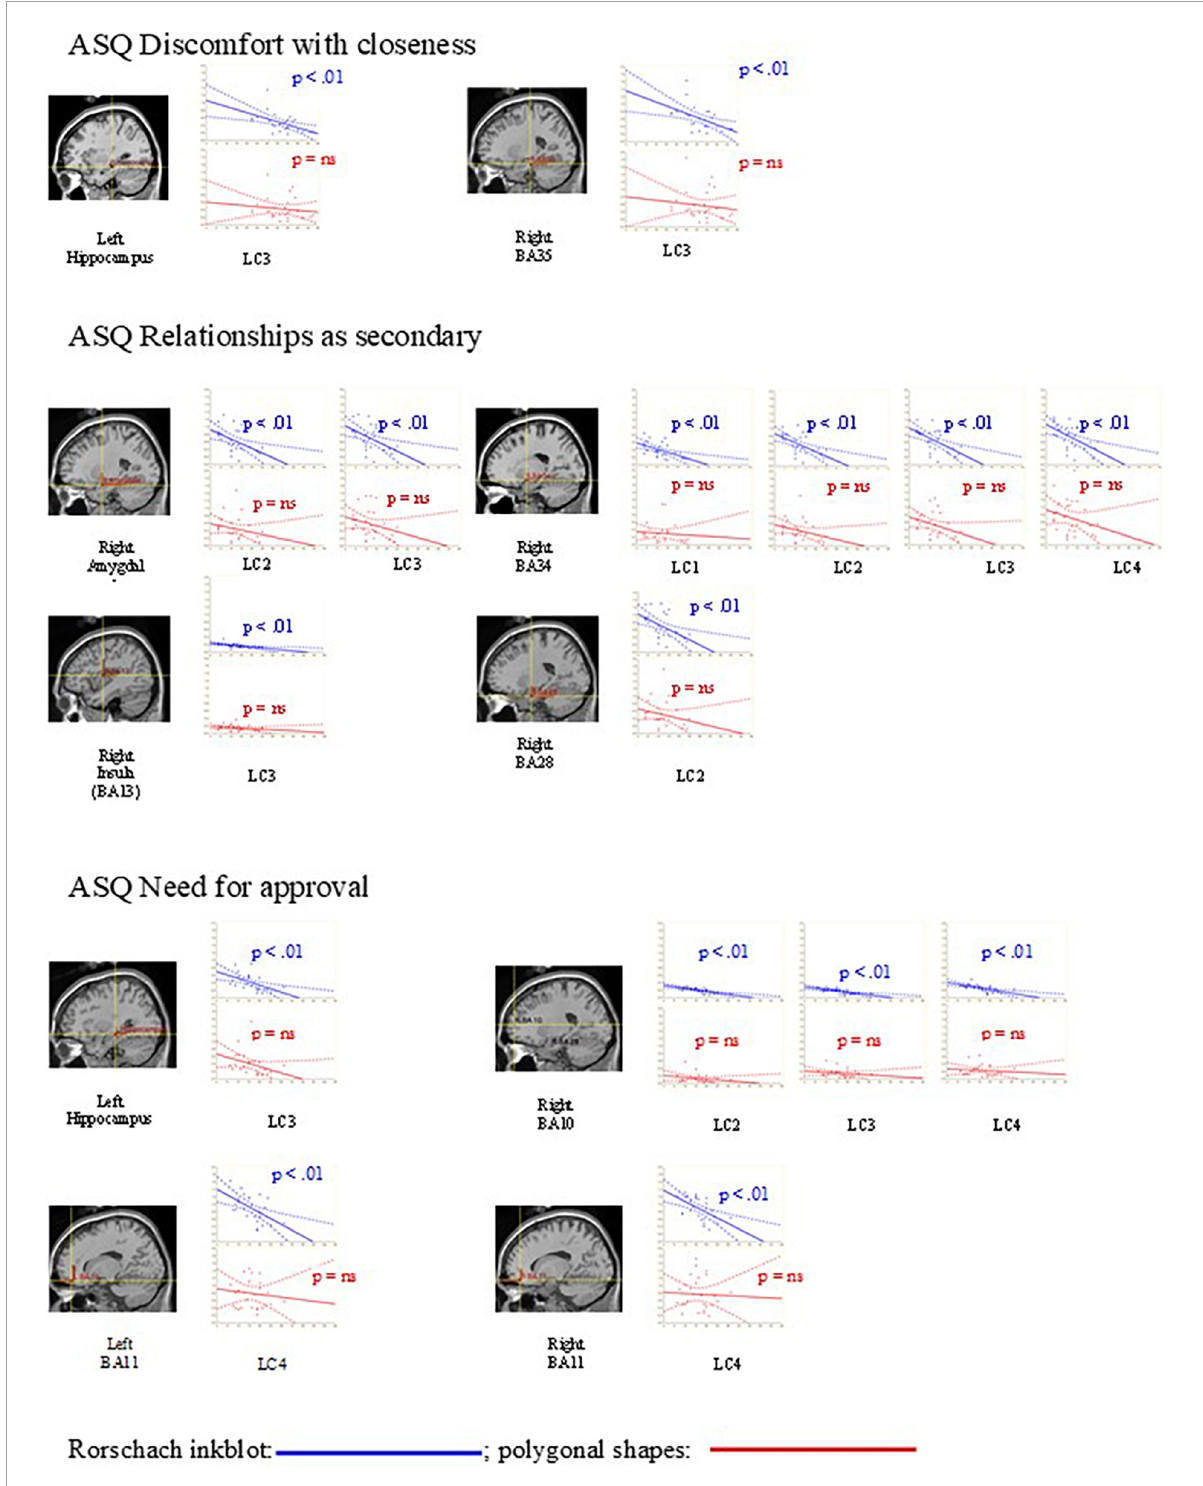
FIGURE2 Scatterplot graphs between attachment dimensions (ASQ discomfort with closeness; ASQ relationships as secondary; and ASQ need for approval) and brain activations in response to the Rorschach inkblots and polygonal shapes. As it is also reported in Table 2 , many associations between attachment dimensions and brain response to the Rorschach inkblots from 200 ms (LC1: 200–300; LC2: 300–400; LC3: 400–500; and LC4: 500–1,000) were significant ( p < 0.01), while there were no significant associations between attachment dimensions and brain response to polygonal shapes ( p =